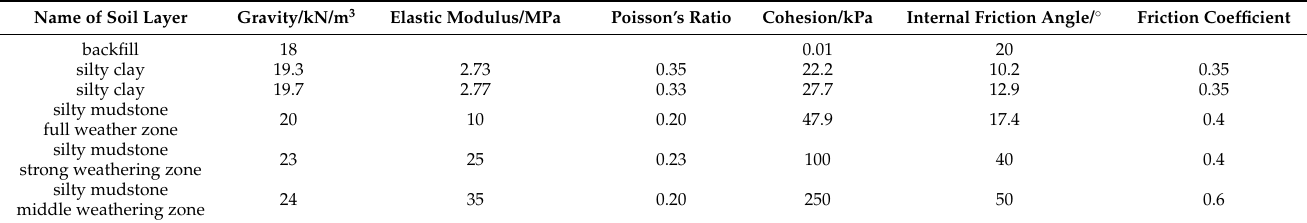
Table 2. Physical and mechanical parameters of undisturbed soil layer.